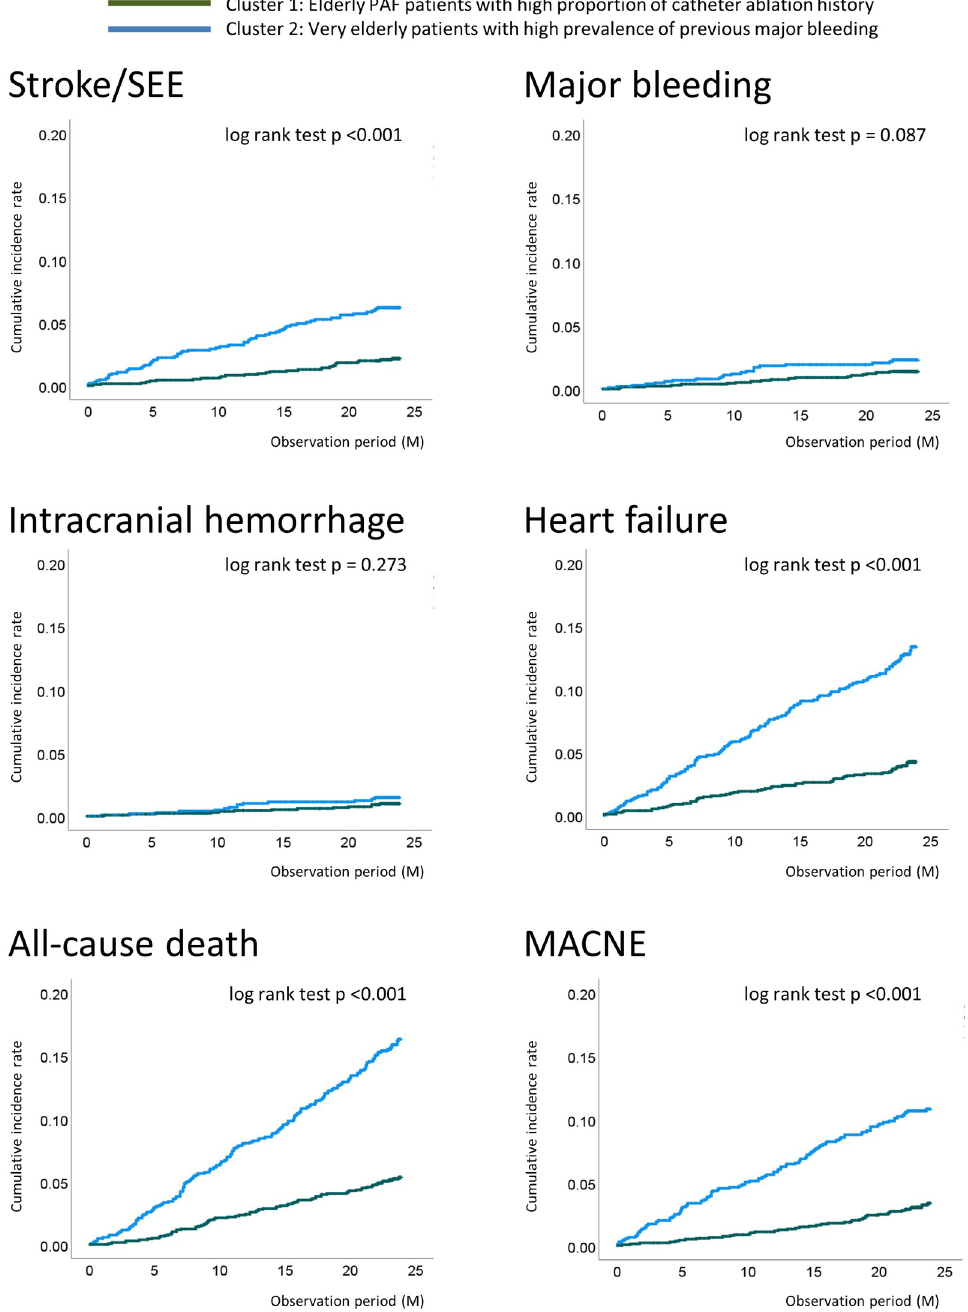
Fig 2. Kaplan–Meier curves for stroke/SEE, all bleeding, major bleeding, intracranial hemorrhage, all-cause death, and major adverse cardiovascular or neurological event. Abbreviations: PAF, paroxysmal atrial fibrillation; SEE, systemic embolic events; MACNE, major adverse cardiovascular or neurological